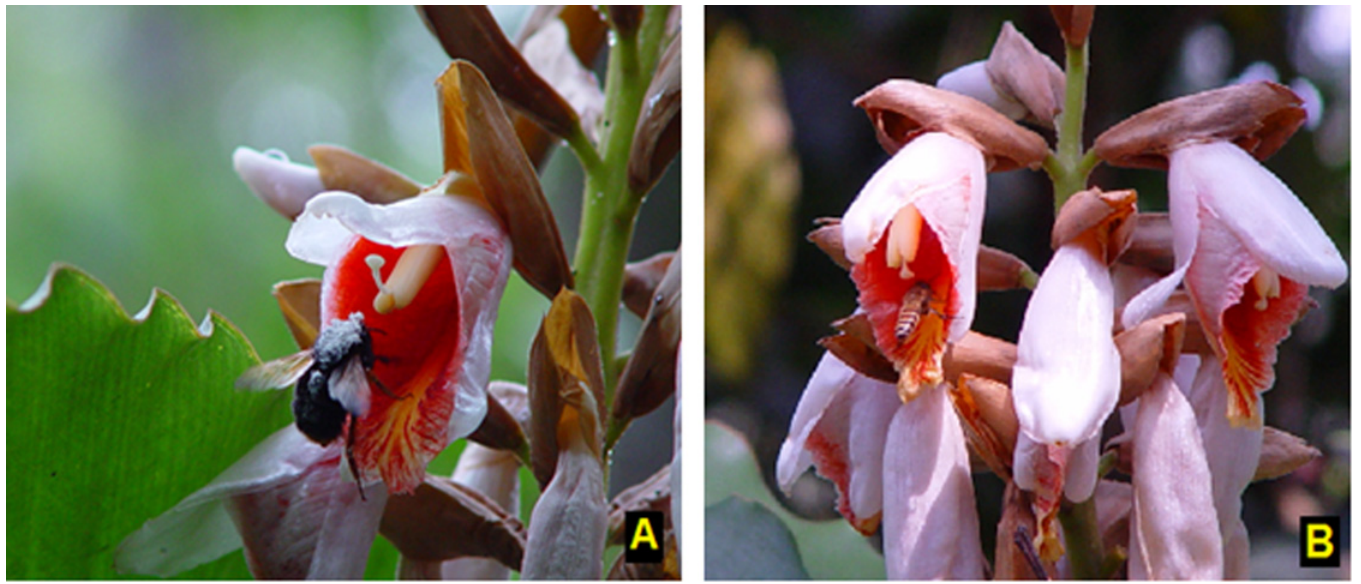
Fig 7. Main pollinators (A) Bombus eximius and (B) Apis cerana pollinating A . roxburghii